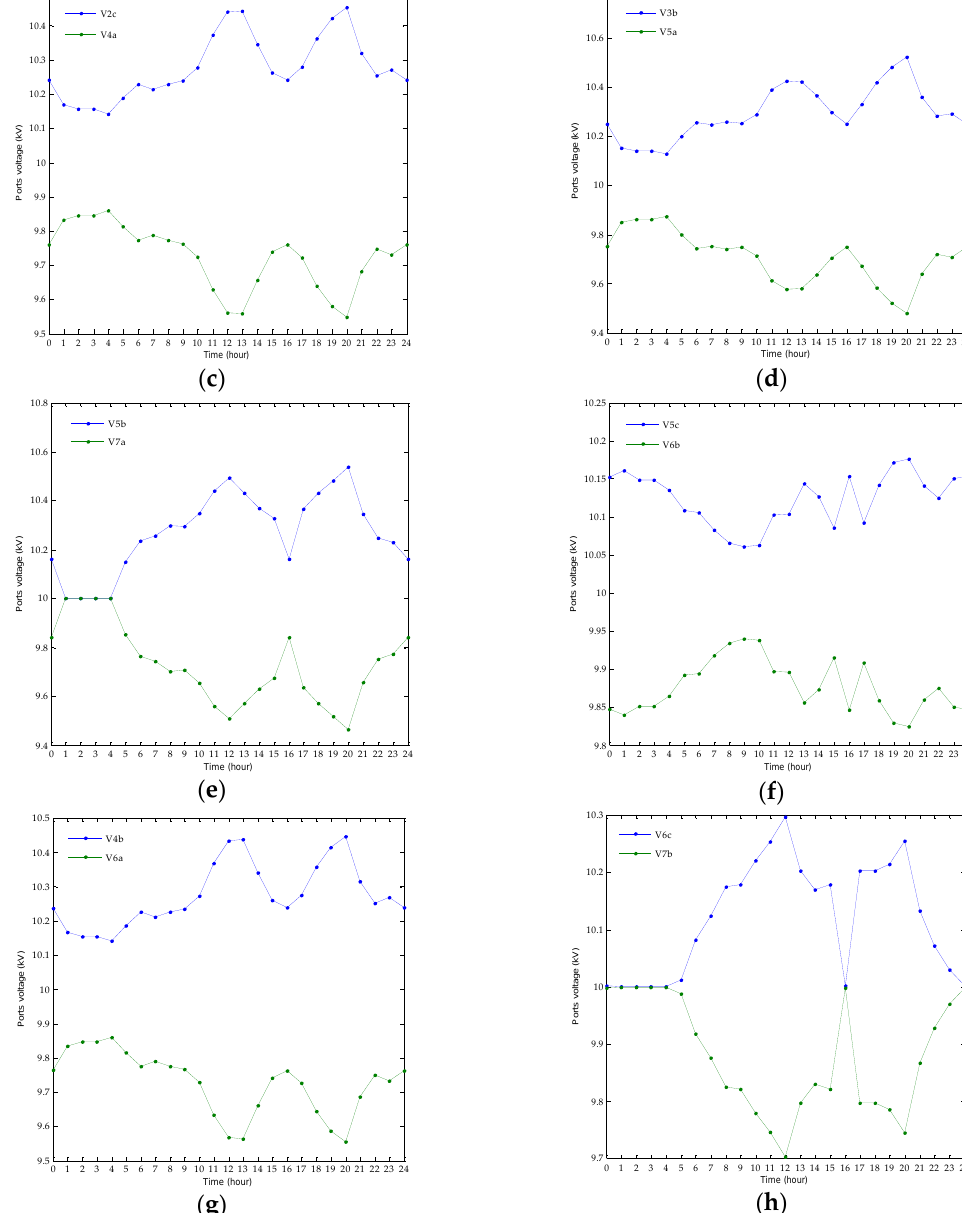
Figure 8. Voltages of the ports connected with connection lines. ( a ) Voltage of both ends of connection line l 1 − 3 ; ( b ) Voltage of both ends of connection line l 2 − 3 ; ( c ) Voltage of both ends of connection line l 2 − 4 ; ( d ) Voltage of both ends of connection line l 3 − 5 ; ( e ) Voltage of both ends of connection line l 5 − 7 ; ( f ) Voltage of both ends of connection line l 5 − 6 ; ( g ) Voltage of both ends of connection line l 4 − 6 ; ( h ) Voltage of both ends of connection line l 6 − 7